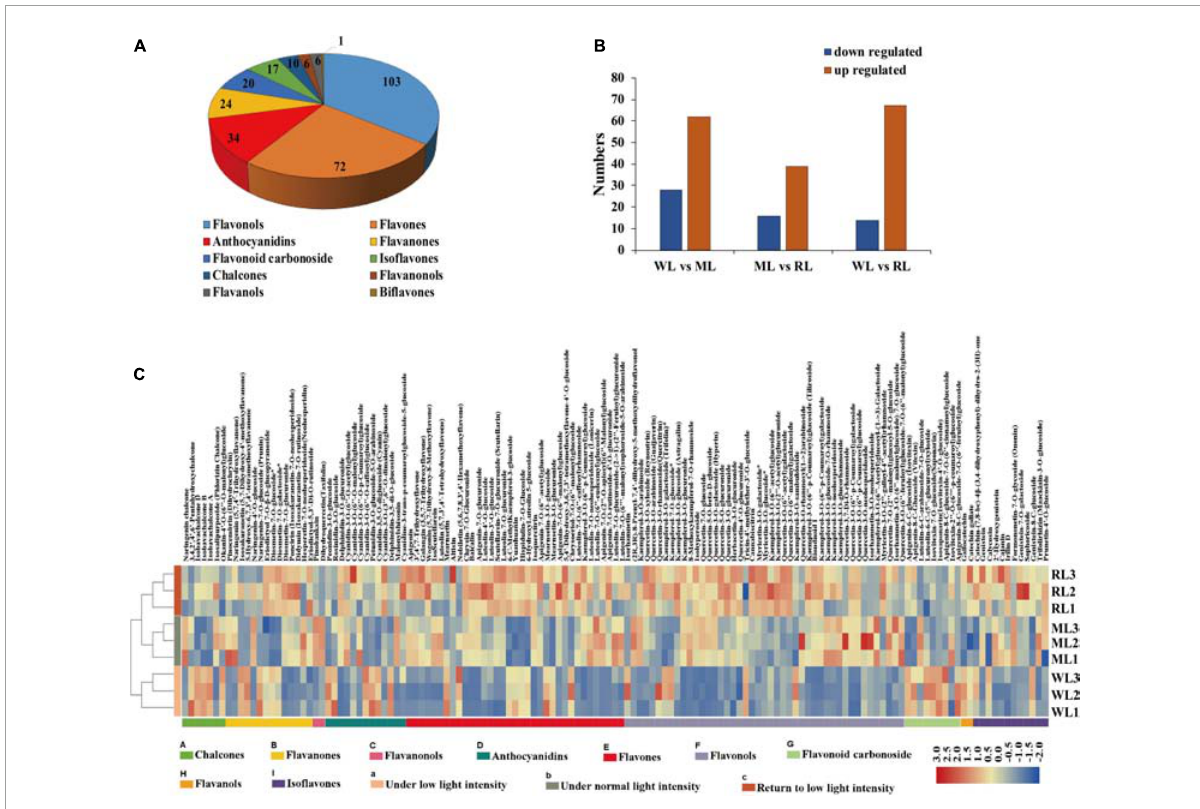
FIGURE2 The flavonoid metabolites of perilla leaves under different light intensity treatments. (A) Types of flavonoid metabolites detected. (B) Differentially expressed metabolites (DEMs) in WL vs. ML6d, ML 6d vs. RL, and WL vs. RL. (C) Contents of flavonoid metabolites in perilla leaves under different light intensity